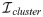
An illustration of the mixing measure.Two cells, labelled by ι1 and ι2, are located at the positions corresponding to the set Icluster at time t. We track their trajectories in the simulated vascular network (dashed black lines) during time tm. The mixing measure is defined as the difference between the distances between these cells at times t and t + tm, d(ι1, ι2, t) and d(ι1, ι2, t + tm), respectively, normalised by the number of cells considered and the maximum distance it is possible to travel in the simulated network. The distance function is defined as a distance within the simulated network (see S1 Text for details).